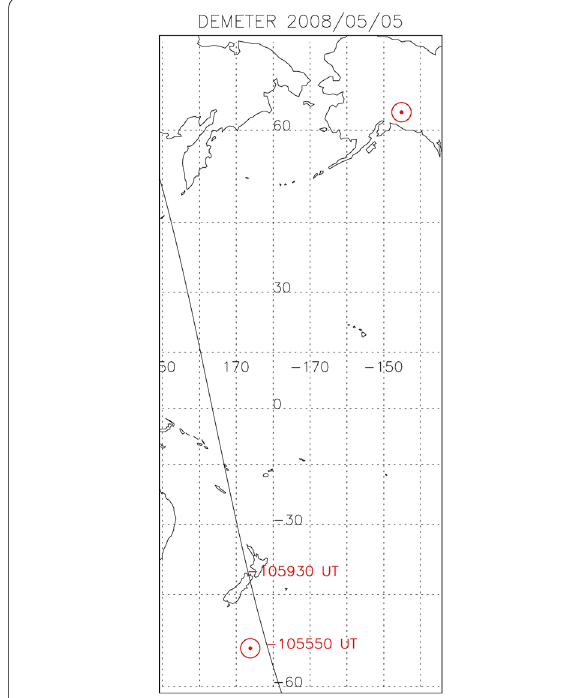
Fig. 9 Spectrograms recorded onboard DEMETER (top panel), at Chistochina (middle panel), and at Juneau (bottom panel) between 10:55:50 and 10:59:30 UT in the frequency range 0–3 kHz. The power spectral density is color-coded according to the scale on the